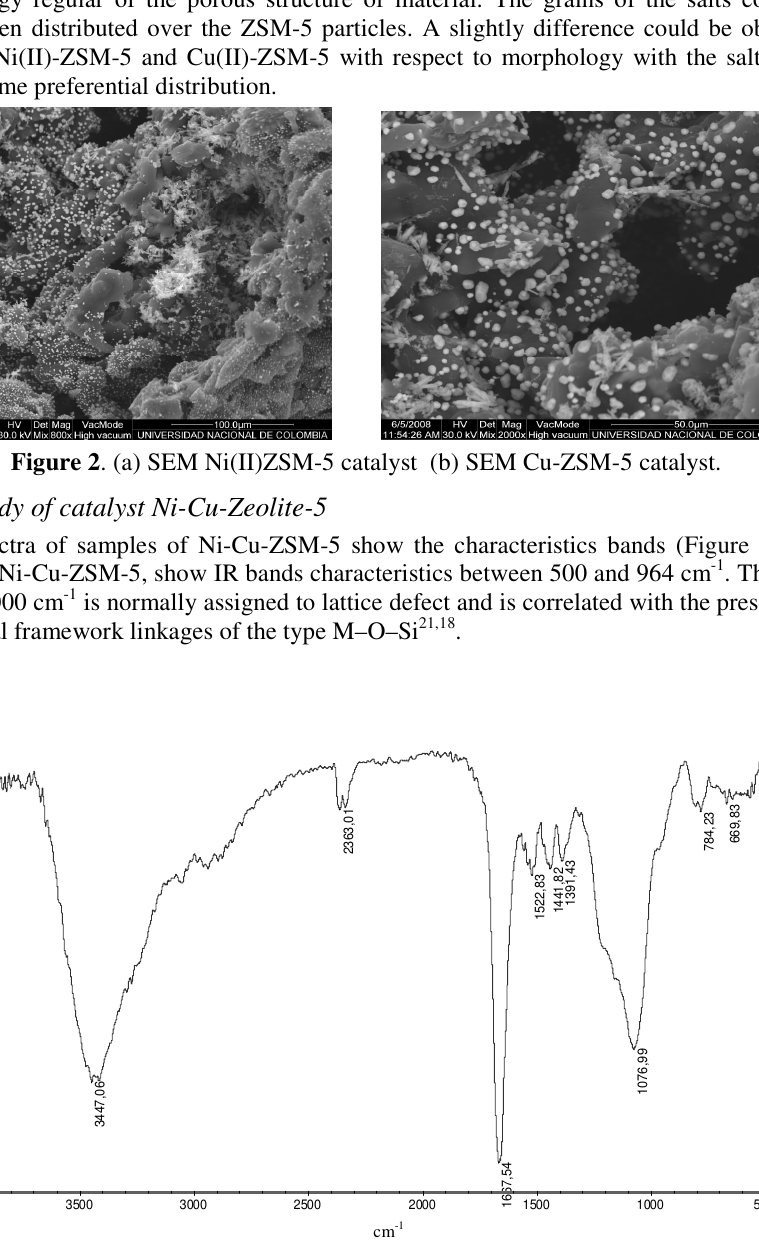
Figure 3. FTIR spectra of Ni-Cu-ZSM-5